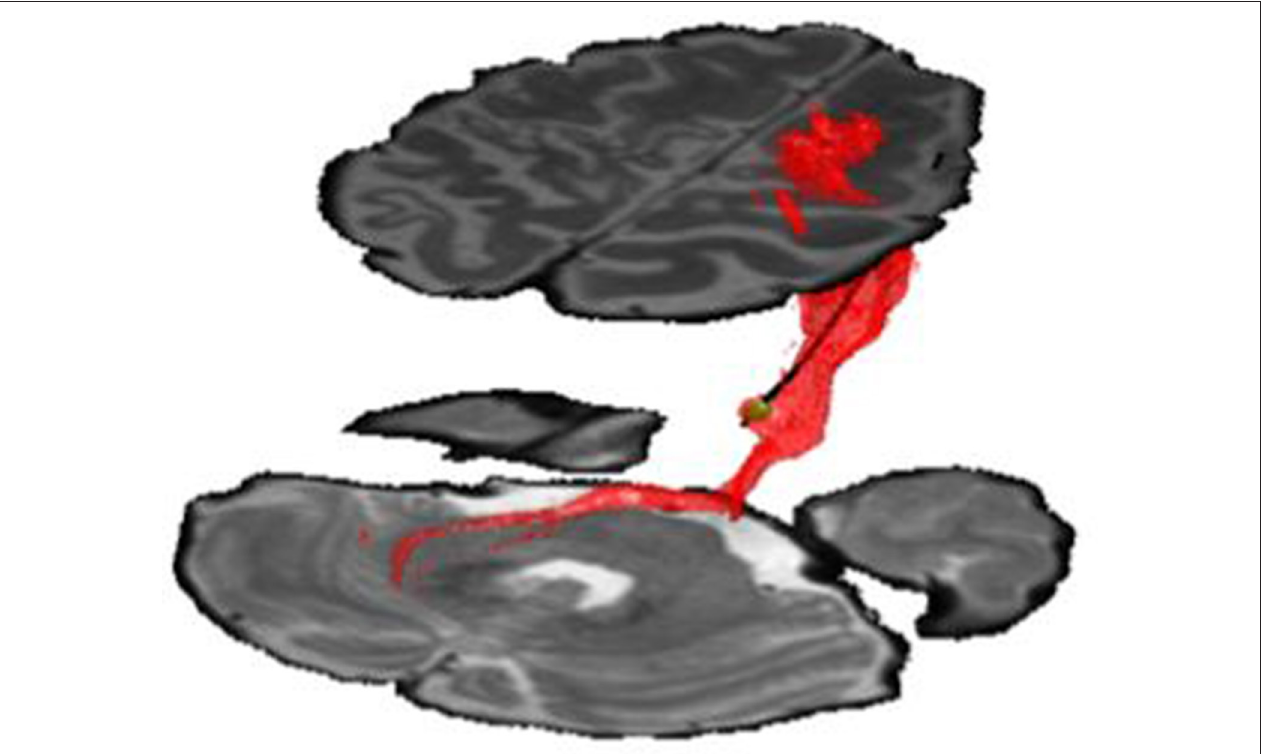
FIguRe 2 | DBS electrode in anatomical location demonstrating volume of tissue activated (green volume). Fibers were generated via computational tractography (red fibers). These fibers were found to project downward to dentate nucleus of cerebellum (lower region), and upward to the premotor and M1-motor strip of the cortex (upper region). Stimulation utilized contact 1 with amplitude −1V and pulse-width 90